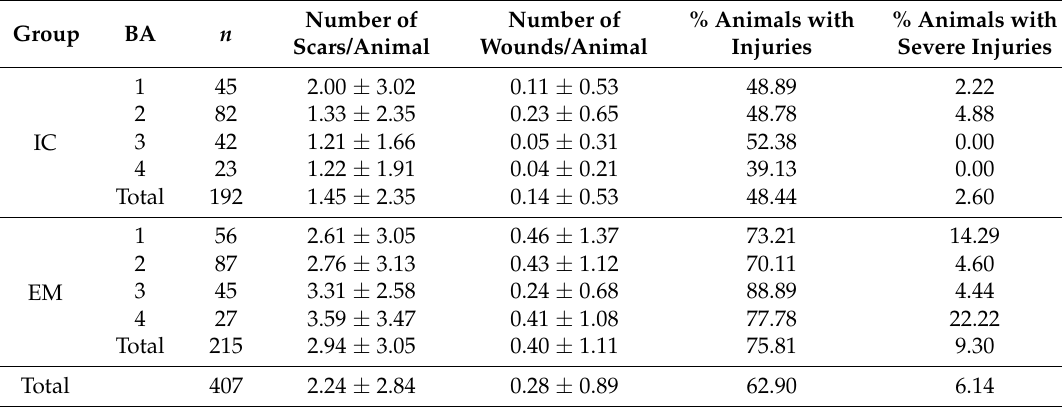
Table 2. Number of scars and number of wounds per animal (mean ± SD), percentage (%) of animals with injuries and with severe injuries of EM and IC per batch (BA) are